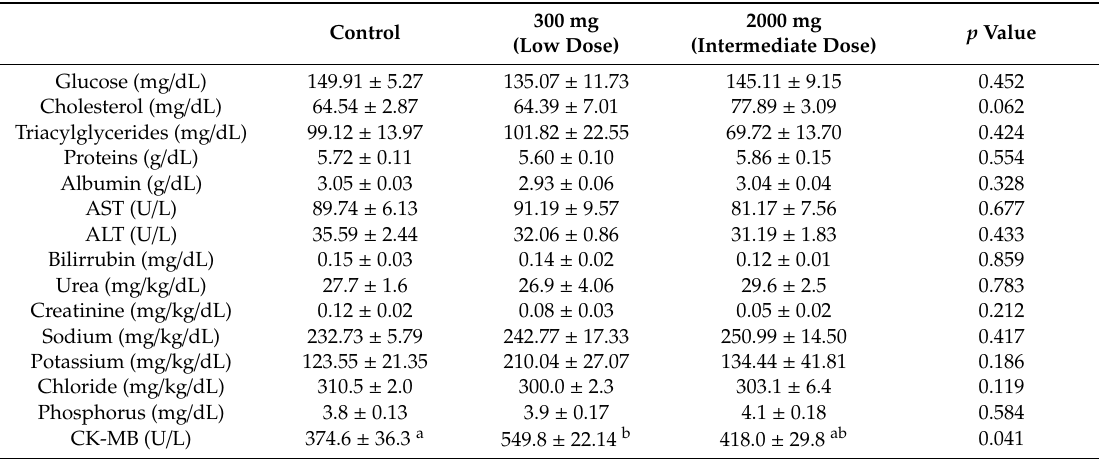
Table 3. Plasma biochemical parameters after 14 days of intervention with di ff erent doses of the VOO